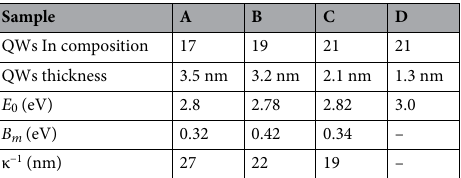
Table 1. Composition, thickness of the different QWs of this study derived by XRD measurements and values of E 0 , B m and κ for sample A, B, C and D.